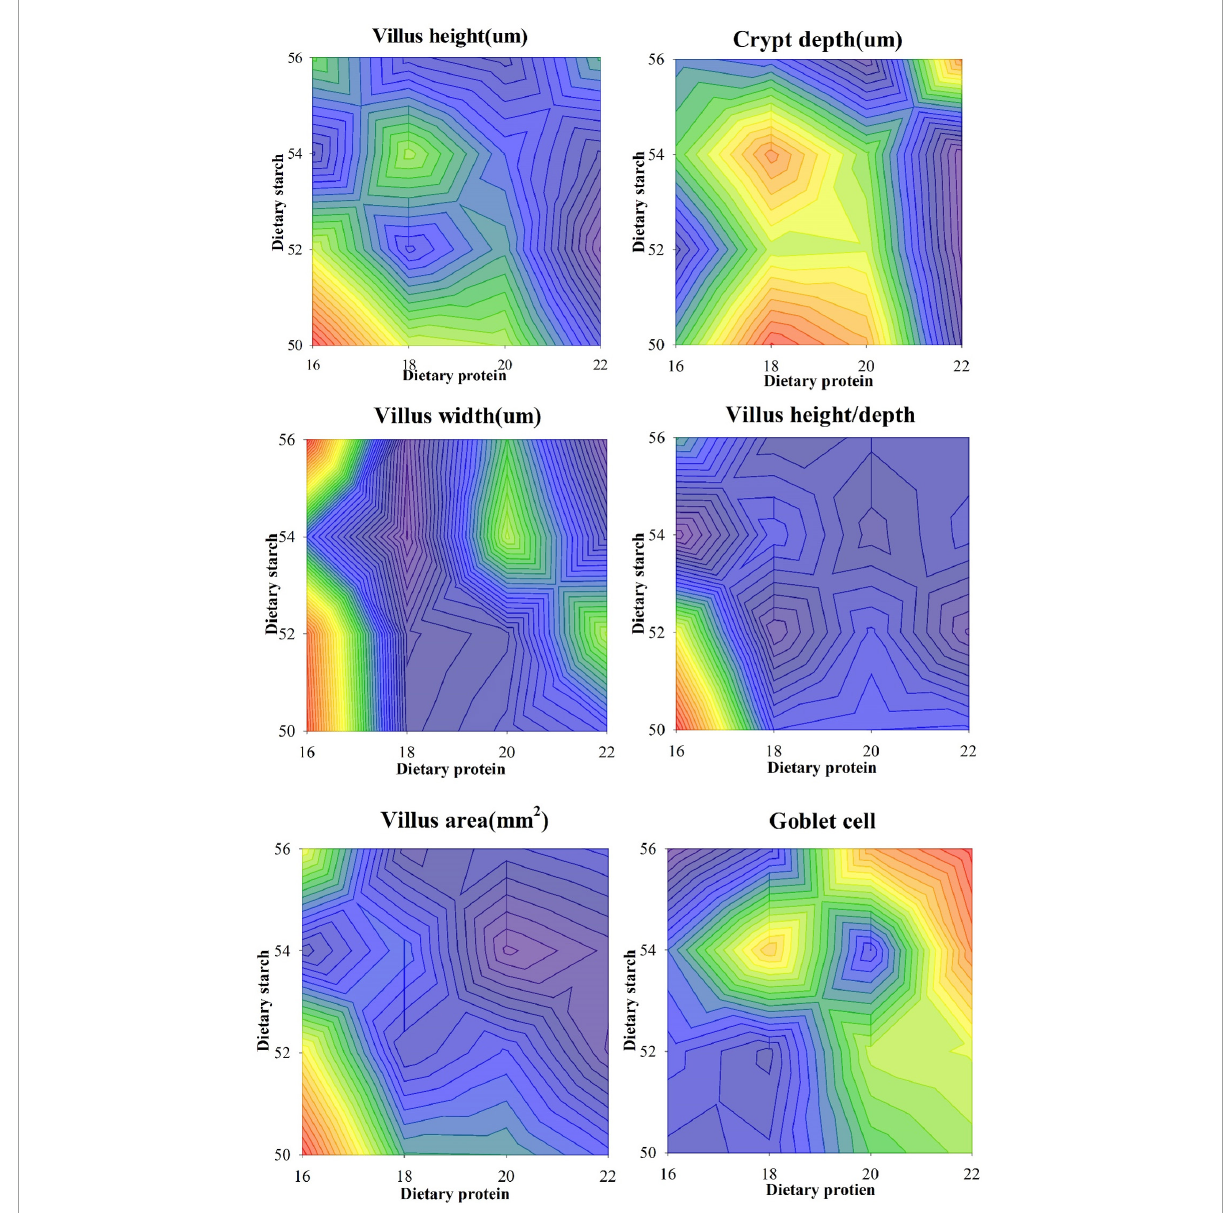
FIGURE4 Effects of different ratios of starch and protein in diet on the structure of ileal epithelium in mice. The value increases with the deepening of red and decreases with the deepening of